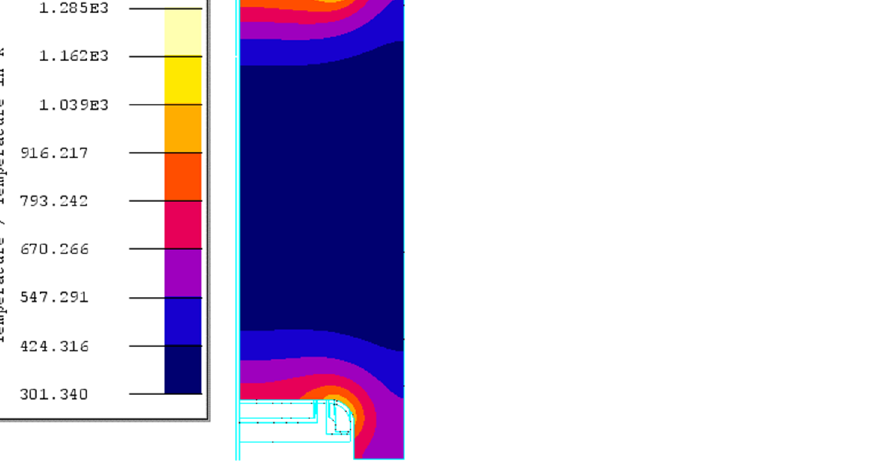
Figure 15. Temperature field of crankshaft N1 during the heating stage (T = 12S).